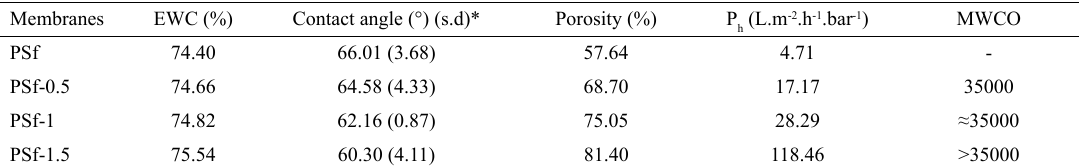
Table 2: Membranes characteristics.